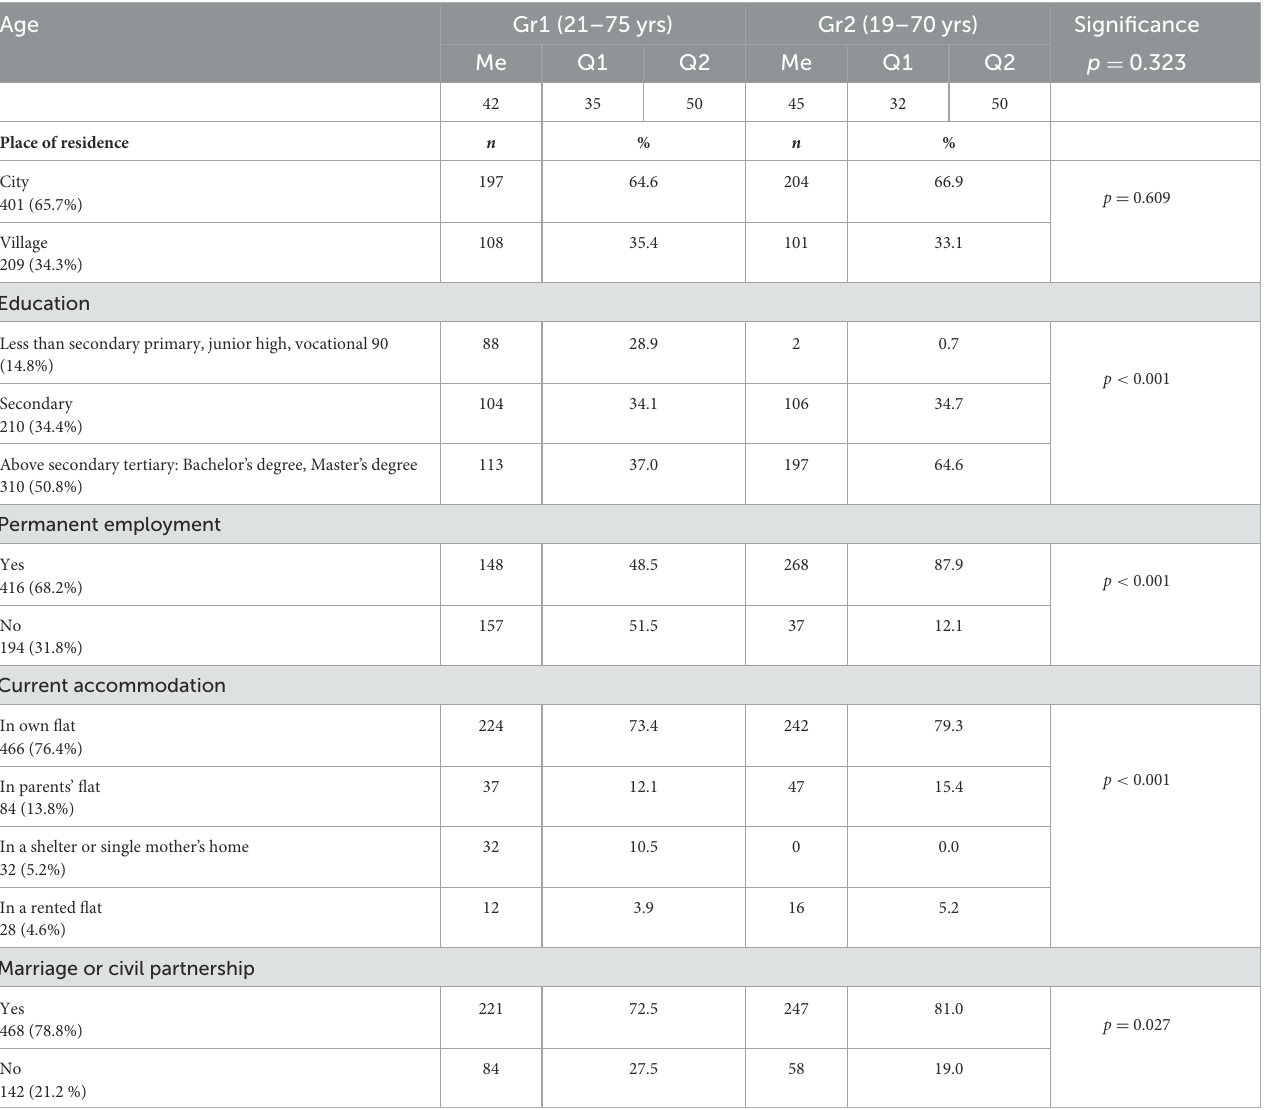
TABLE 1 Sociodemographic data of the participants.